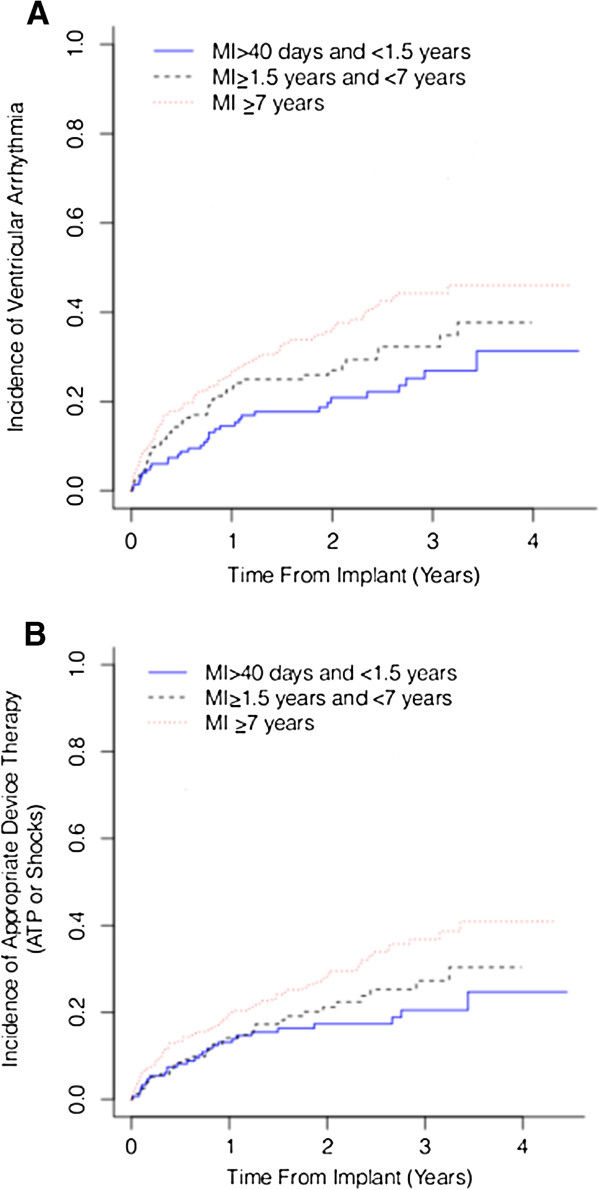
Cumulative incidence estimates of ventricular tachyarrhythmias (panel A) and appropriate device therapy (ATP or shock) (panel B) in patients with a prior MI ≥7years (dotted red line), MI ≥ 1.5 years and <7 years (dashed black line) and MI >40 days and <1.5 years (blue line).